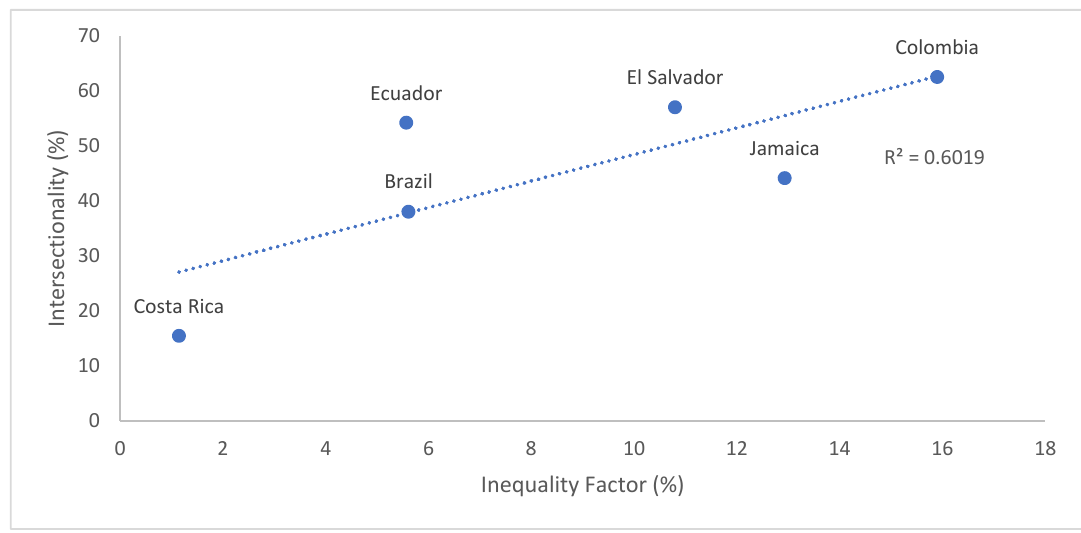
Figure 11. Relationship between analyses of access to water services by intersecting forms of inequality and by inequality factors. Source: Based on census microdata from the IPUMS-International Project [25].